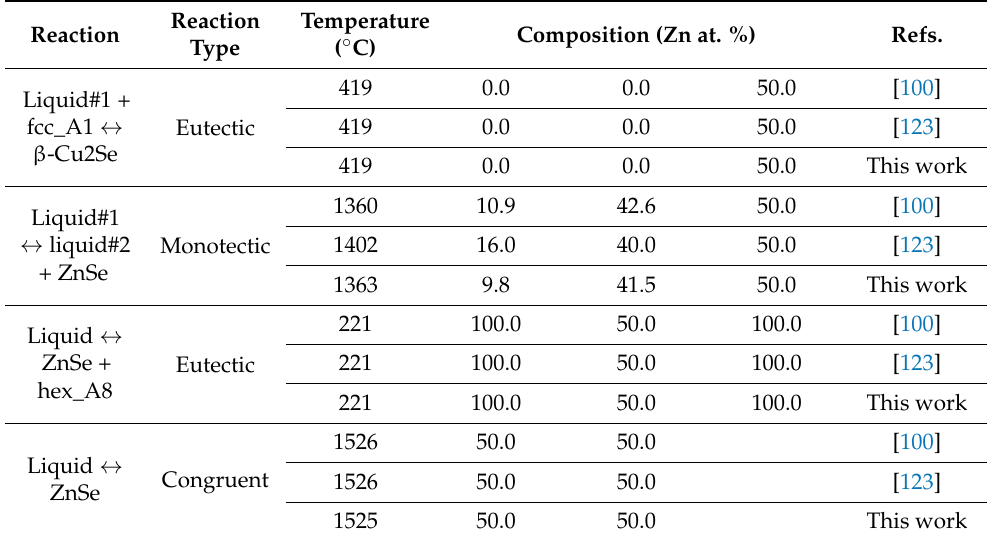
Table 9. The calculated invariant reactions in Zn-Se system compared with experimental data from ref. [100] and calculated data from ref. [123].